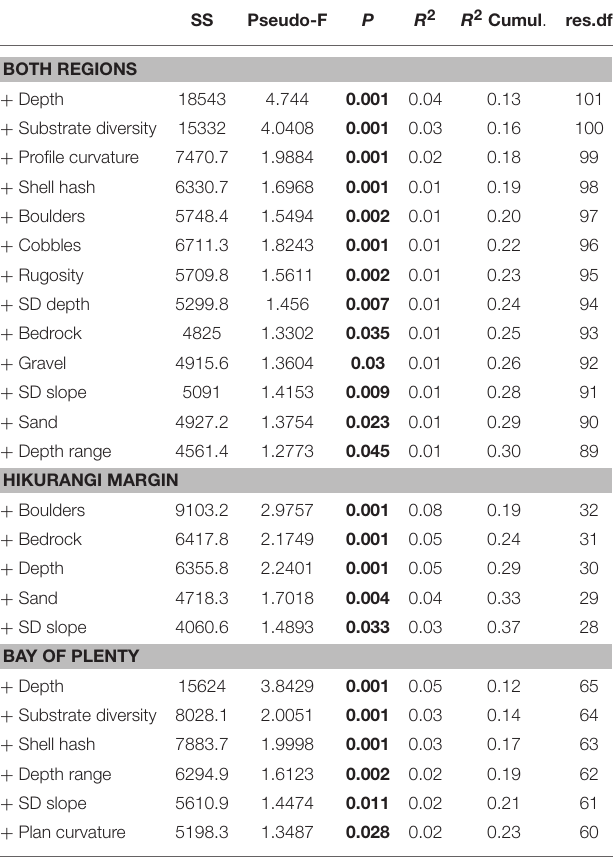
TABLE 3 | Results of distance-based linear model (DistLM) analyses showing correlations between predictor variables and megafaunal community structure (sequential tests) for Hikurangi Margin and Bay of Plenty regions combined, and each region